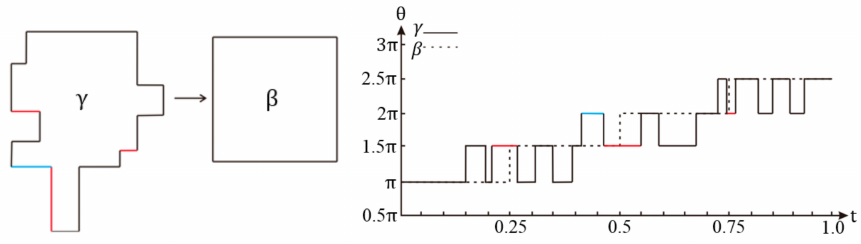
Figure 4. Matching of building sides based on the turning angle function.